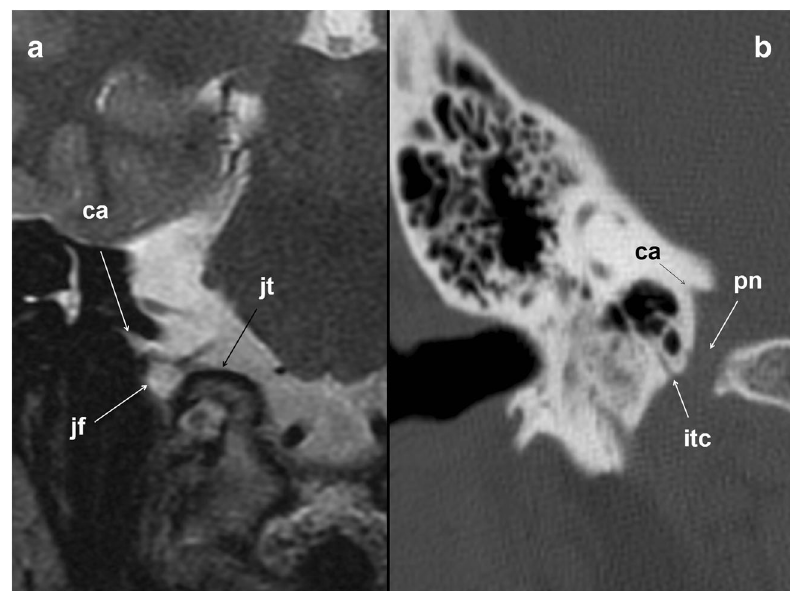
Fig. 4 The glossopharyngeal nerve at the jugular foramen. a Coronal T2-weighted brain MRI at the level of the jugular foramen (jf). The image shows the relationship between the cochlear aqueduct (ca) above, and the jugular foramen and jugular tubercle (jt) below. b Skull base CT scan; coronal reconstruction of the right temporal bone, bone window. The image shows the inferior tympanic canaliculus (itc) for the inferior tympanic or Jacobson ’ s nerve at the jugular spine. ca: cochlear aqueduct; pn: pars nervosa